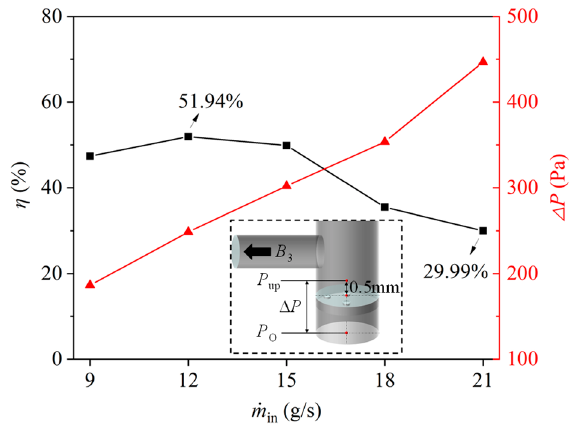
Figure 4. Vapor-liquid separation efficiency and the pressure difference across the orifice-baffle.